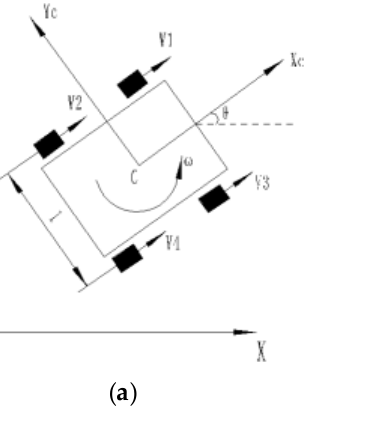
Figure 4. Kinematic models. ( a ) four-wheel differential model, ( b ) Simplifying the